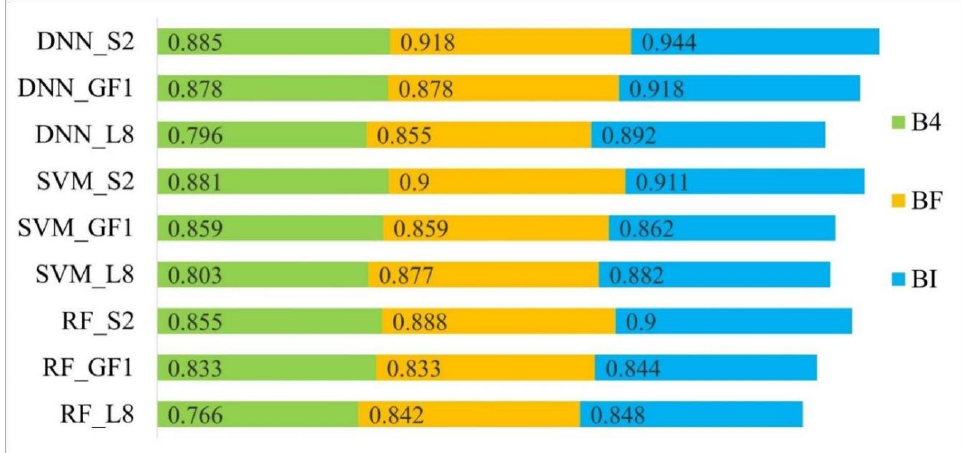
Figure 13. Overall accuracy of the 27 models. Table 4. Area of Chinese pine (CP) and Karaqin Banner (KB) calculated within the 27 models.